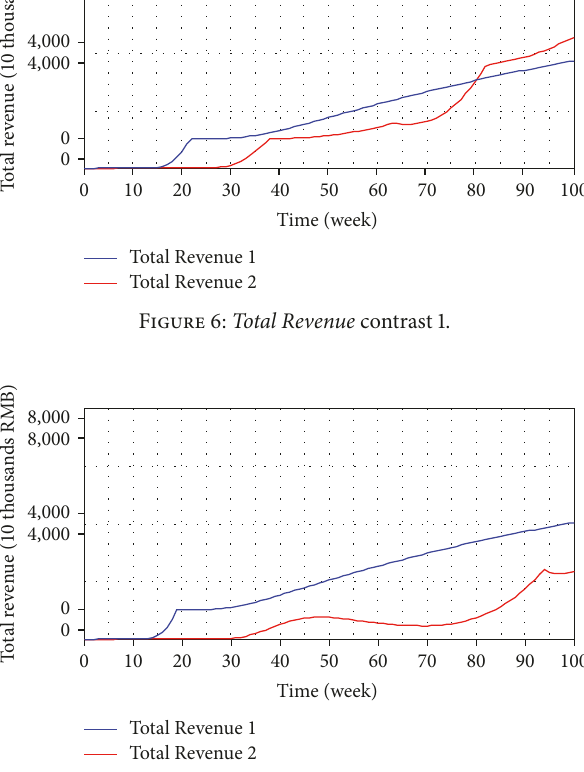
Figure 7: Total Revenue contrast 2.